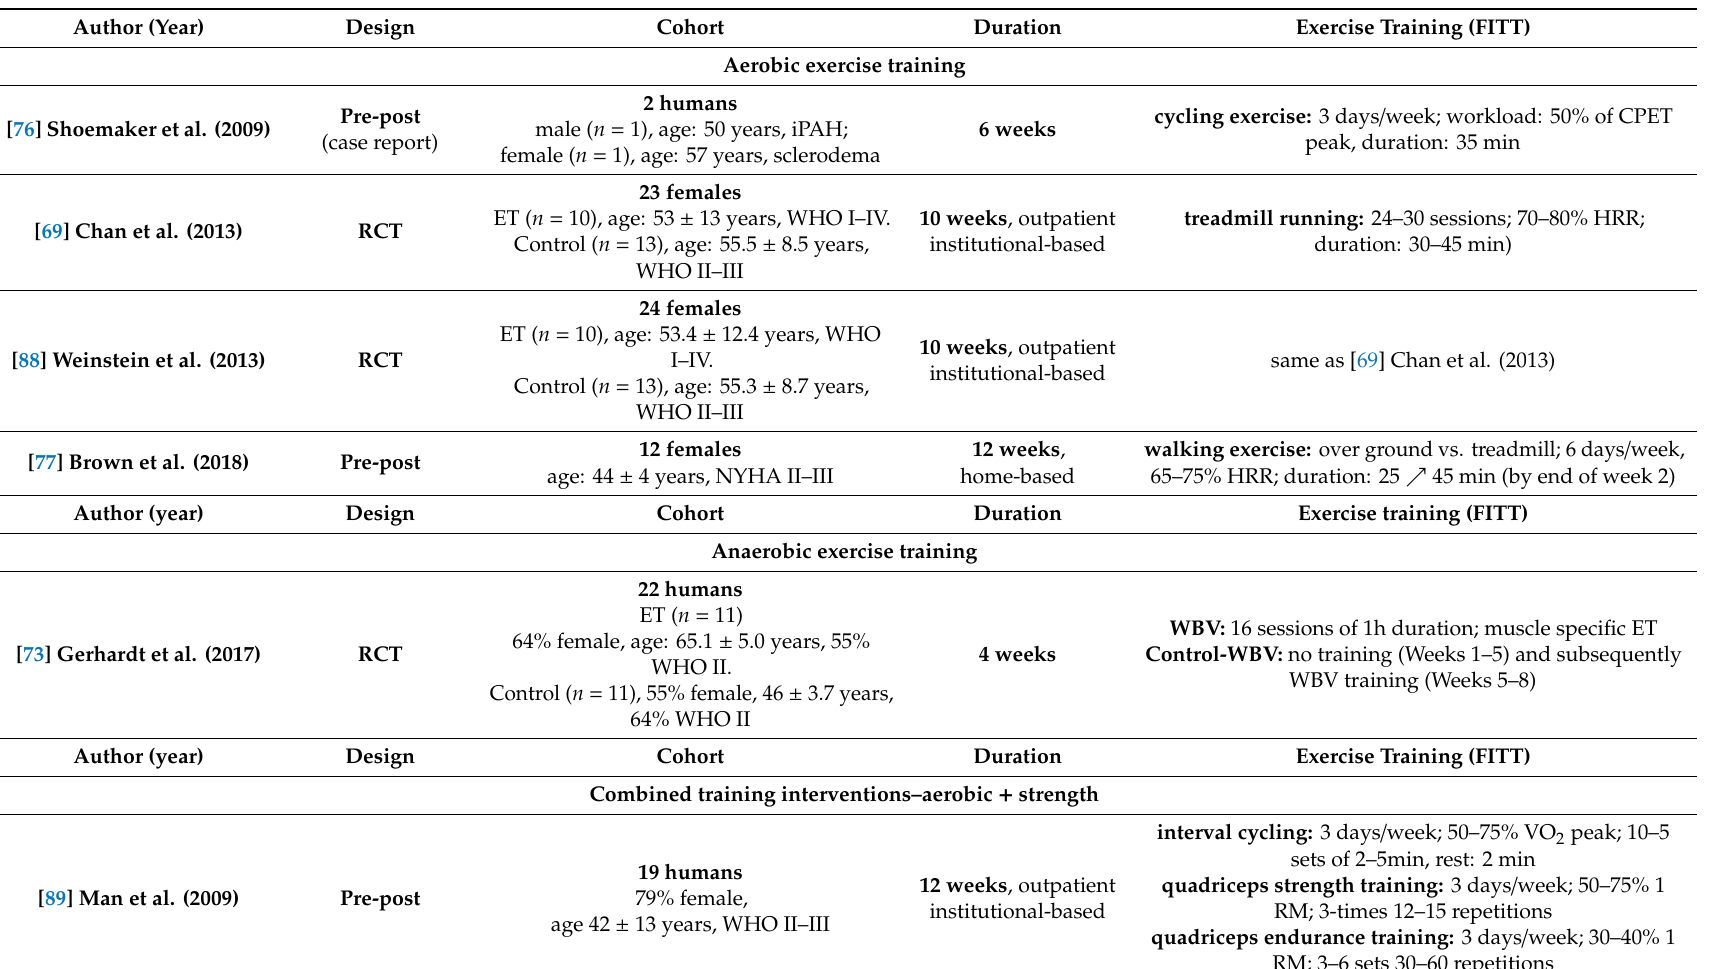
Table 4. Characteristics of included exercise training studies in humans ( n =